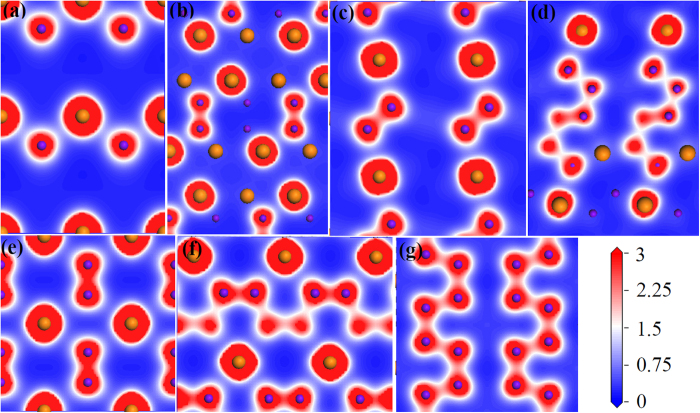
Calculated valence electron density distributions of Ru nitrides.(a) I-4m2-RuN in (100) plane; (b) R-3m-RuN in (110) plane; (c) Pnnm-RuN2 in (001) plane; (d) P21/c-RuN3 in (101) plane; (e) P4/mmm-RuN4 in (010) plane; (f) C2/c-RuN4 in (001) plane and (g) Cmmm-RuN4 in (001) plane. The big orange and small purple spheres represent Ru and N atoms, respectively.